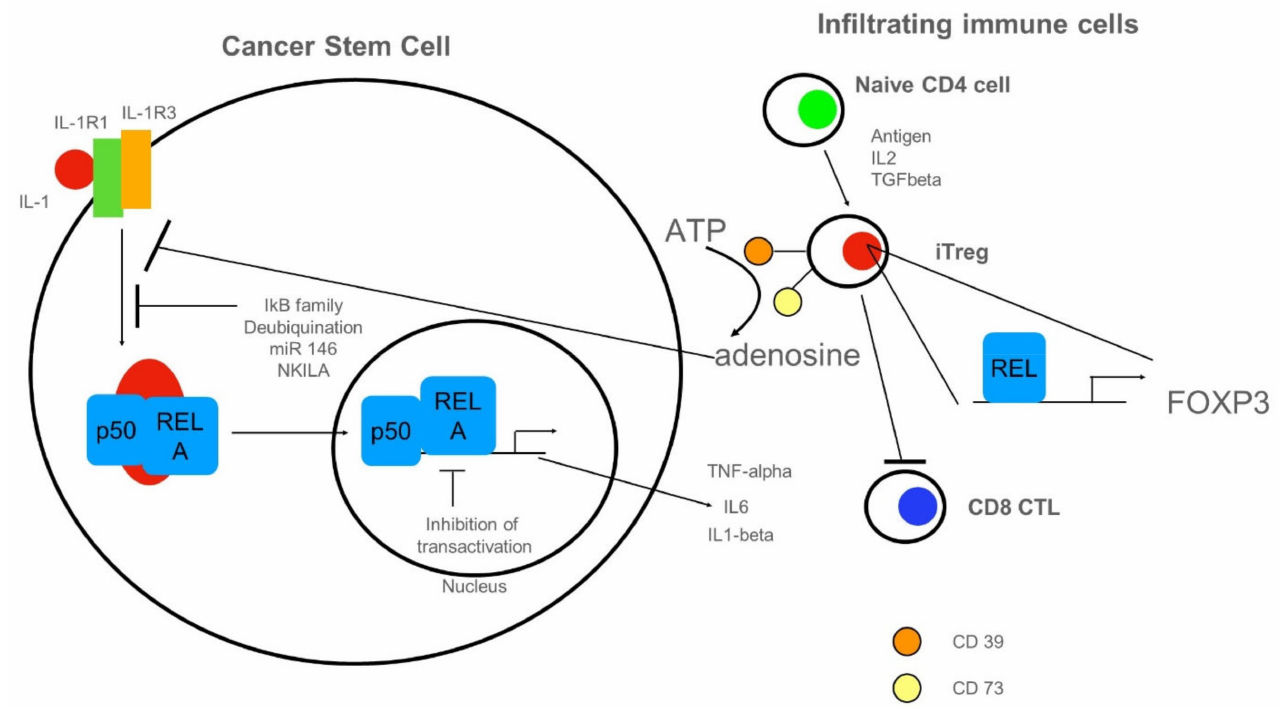
Figure 4. Anti-inflammatory cues impinging on NF- κ B in CSCs. On the left, a CSC with NF- κ B- signaling is depicted. NF- κ B could be activated by cancer-produced IL-1. Inhibition of NF- κ B- activation could be mediated by several members of the I κ B family, by the de-ubiquitination of signaling molecules (for details see text). Furthermore, non-coding RNAs such as microRNA(miR) 146 or long non-coding RNAs NKILA could inhibit NF- κ B-activation by targeting activating proteins. Inhibition of transactivation could be driven by IEX-1 or by COMMD1-mediated ubiquitination of RELA. On the right side, tumor-infiltrating immune cells are shown. Naïve CD4 + cells can differentiate into induced regulatory T cells (iTregs). These express ectoenzymes such as CD39 and CD73 responsible for the hydrolysis of ATP to adenosine, in turn, inhibiting NF- κ B-activation in CSCs. iTREGs could fancy cREL for expression of FOXP3 lineage transcription factor. A pro-tumor function of iTREGs could be the repression of CD8 cytotoxic lymphocytes